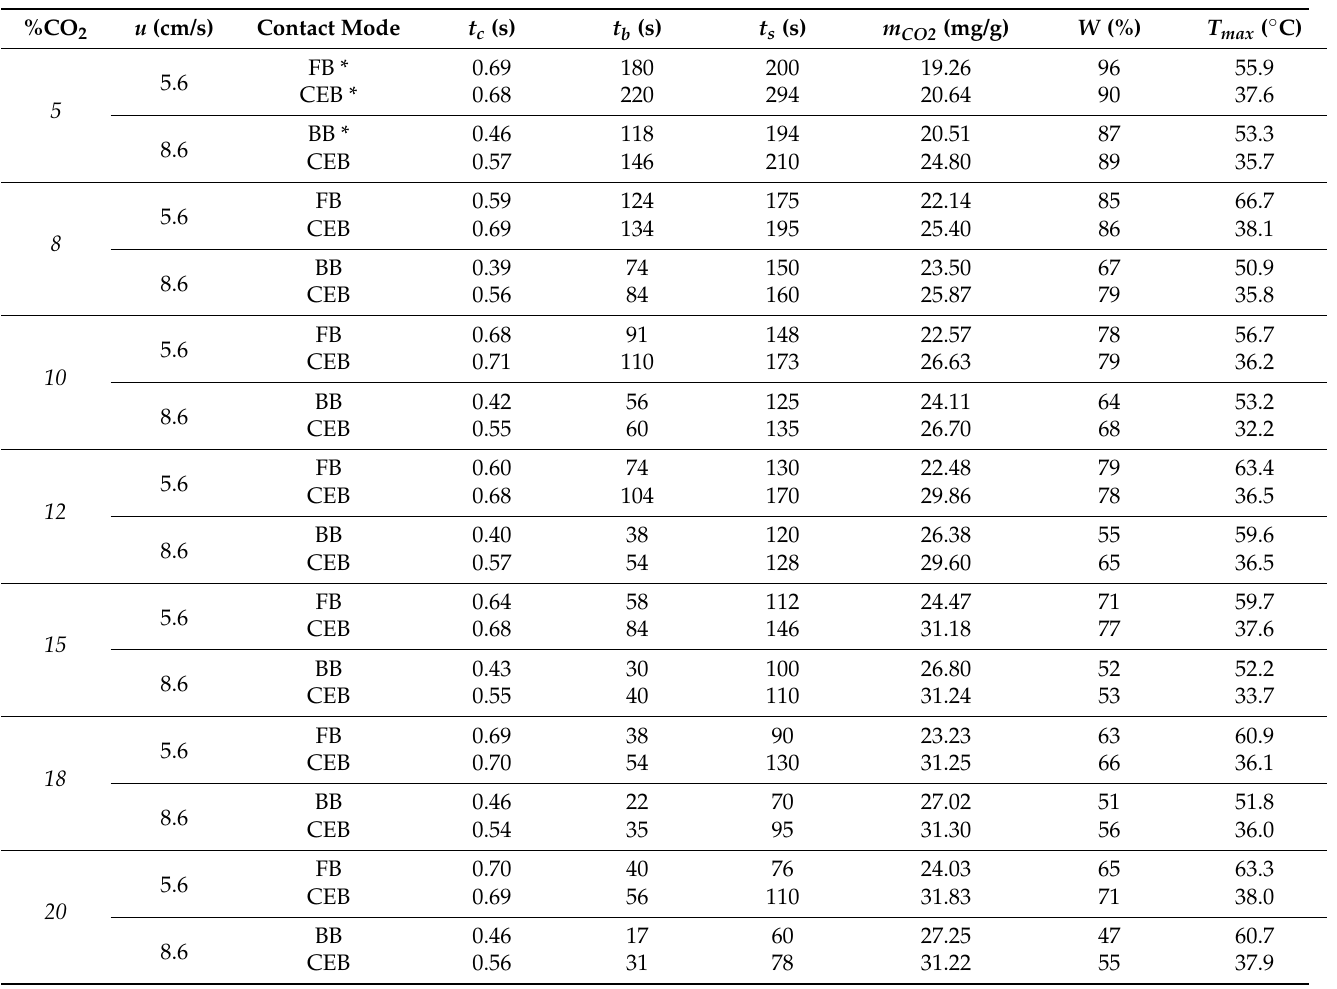
Table 7. Adsorption capacity of amine-modified silica from literature.